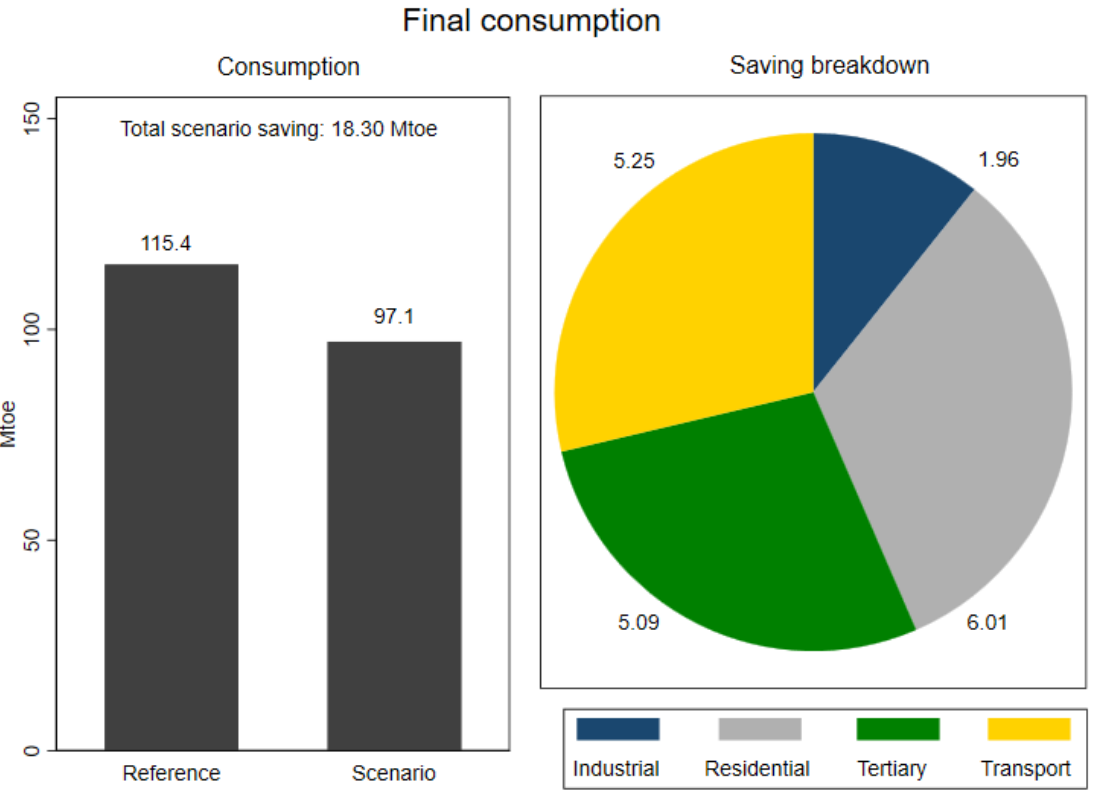
Figure 1. Consumption and final consumption savings by 2030. Note that reference stands for 2019 data.